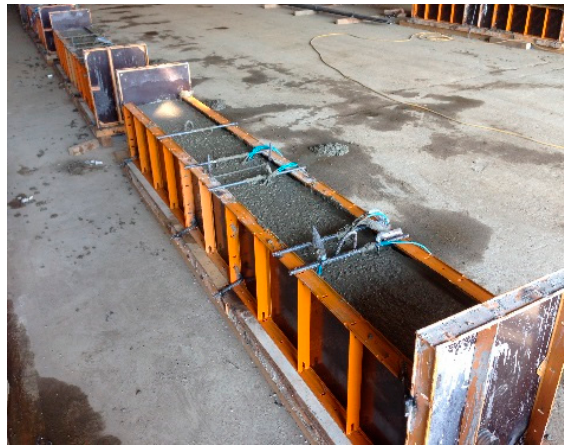
Figure 10. Match casting.